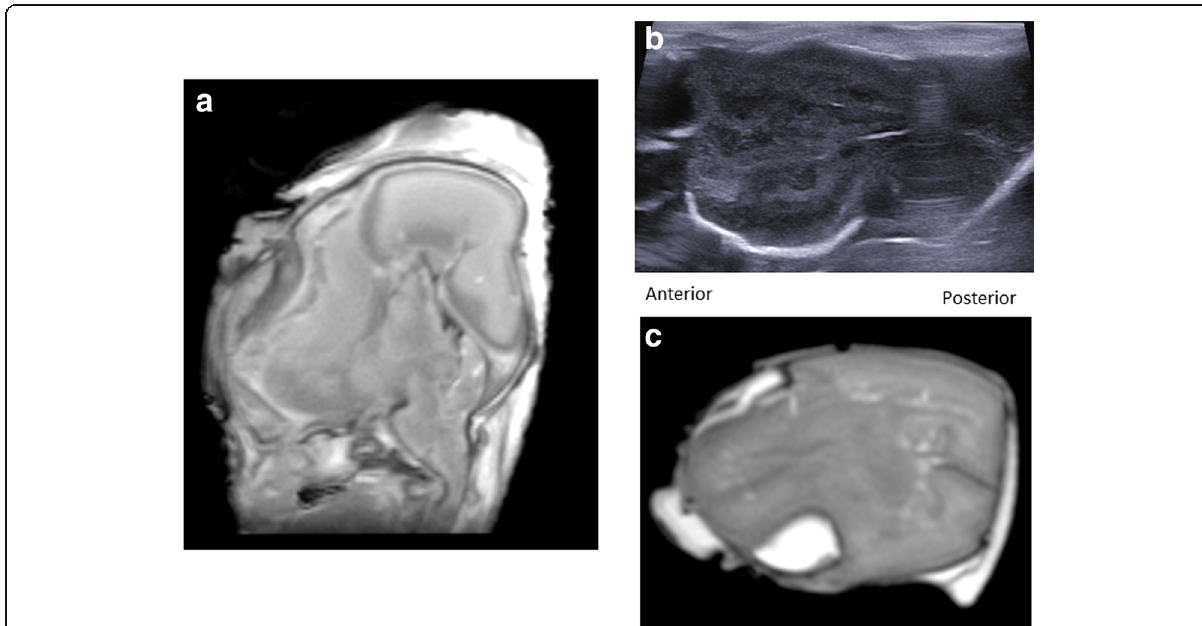
Fig. 5 Images of delivery and maceration related changes that degrade postmortem ultrasound image quality in a 22-week gestational-aged foetus. Sagittal T2-weighted postmortem MRI at 1.5 T ( a ) through the midline shows soft tissue oedema of the scalp, overlapping cranial sutures and underlying brain maceration. On the corresponding left trans-temporal view of the brain at postmortem ultrasound ( b ) and at axial postmortem MRI ( c ) at the level of the midbrain, it is difficult to delineate normal brain parenchymal architecture. In such cases, the imaging is described as ‘ non-diagnostic ’ and useful information cannot be gleaned by either imaging